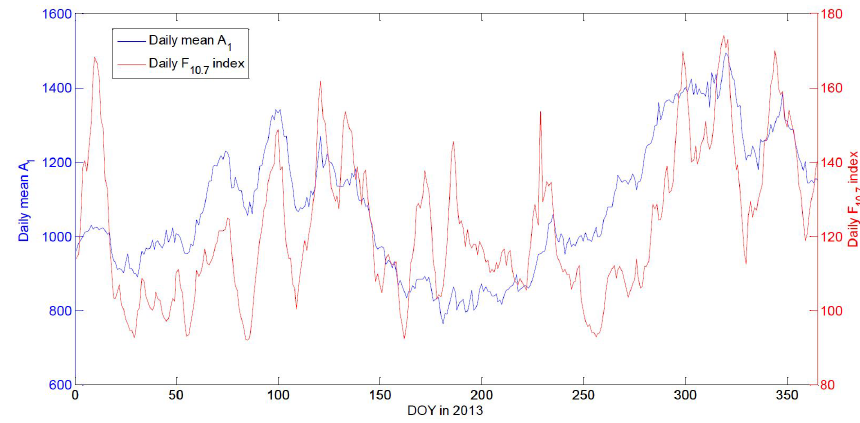
Figure 6. Daily mean first EOF coefficient A 1 and daily solar F10.7 index. Table 2. Variances of the base function, correlation coefficient, and bias statistics among the base functions of GIM-TEC and